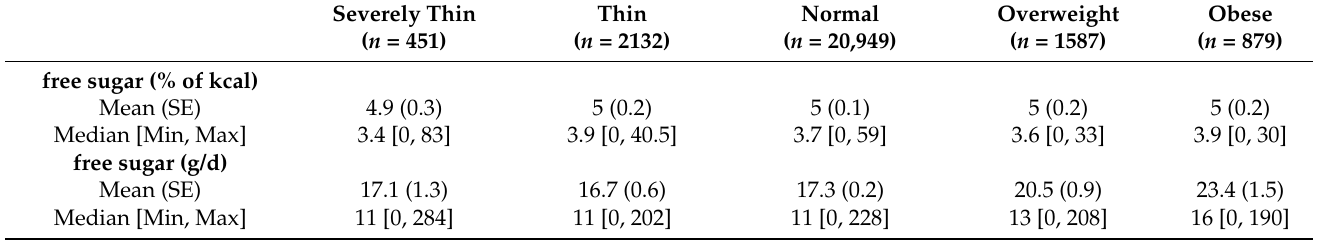
Table 9. Intakes of free sugars by BAZ (BMI adjusted for age) status (age range 4–19).